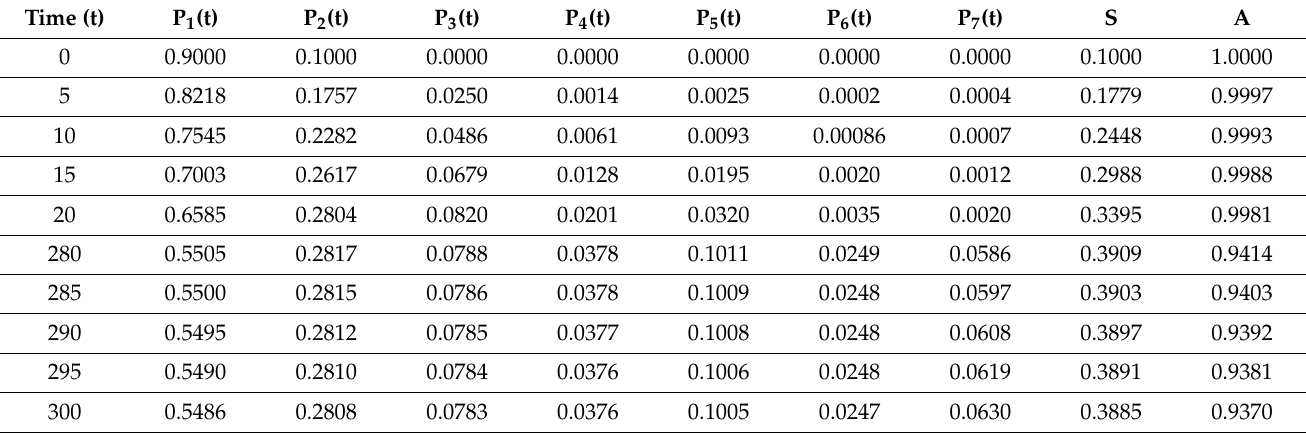
Table 2. The probability results of each state for Case 1 ( k = 0.005, v = 0.001, w =